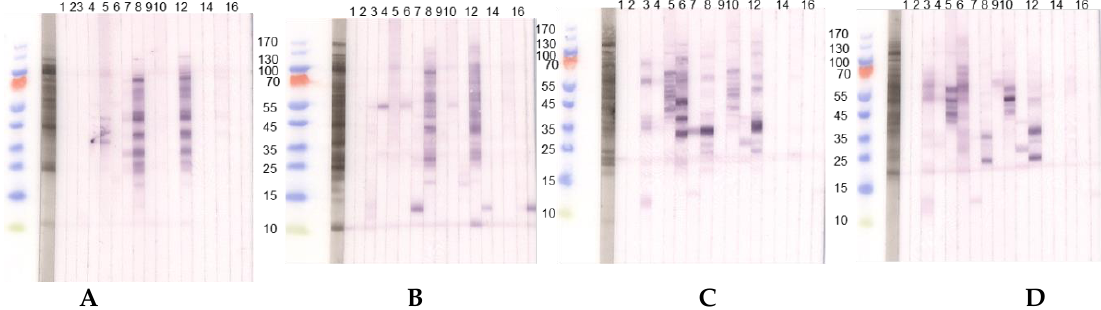
Figure 2. Immunoblots with acidic extracts (0.1 M CH 3 COONH 4 , pH 5.0), TTBS blocking and dilution of sera 1:10 with two different lupine species, ( A ) L. angustifolius and ( B ) L. luteus chosen as examples. (1) Tris control; (2) negative control serum; (3) lupine and peanut allergy (P 6); (4) legume allergy, suspected lupine allergy, lupine-sensitized (P 2); (5) peanut allergy, suspected lupine allergy, lupine-sensitized (P 3); (6) lupine allergy (P 23); (7) lupine allergy (P 10); (8) peanut allergy, lupine-sensitized (P 24); (9) lupine and peanut allergy (P 25); (10) lupine and peanut allergy (P 26); (11) peanut allergy, suspected lupine allergy (P 27); (12) peanut allergy, lupine-sensitized (P 4); (13) peanut allergy, lupine-sensitized (P 13); (14) lupine allergy (P 29); (15) peanut allergy and suspected lupine allergy (P 28); (16) suspected lupine allergy, lupine-sensitized (P 14); (17) peanut allergy, lupine-sensitized (P 12). (C , D) Immunoblots with alkaline extracts (0.2 M NH 4 HCO 3 , pH 8.0) of ( C ) L. angustifolius and ( D ) L. luteus with sera from the same patients. For sera from some individuals (P 4, P 10, P 12, P 13, P 14) differences regarding the IgE-reactivity to different lupine species are detectable. Particularly, sera from P 10, P 12, and P 13 showed reactivity to one LMW protein in the L. luteus extract, which we decided to work upon further since the reactivity was dominant when compared to weak or missing reactivity to other proteins in the extract. (P-code corresponds with Table 1.).